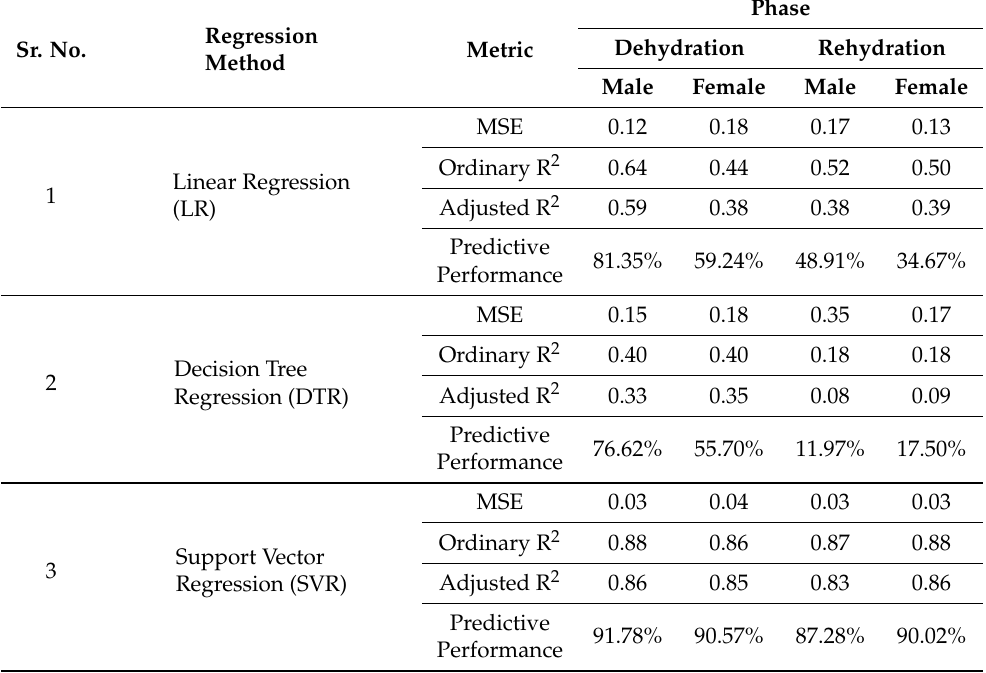
Table 9. Results for sex-specific analysis—Case 2: training separate models using data from male and female